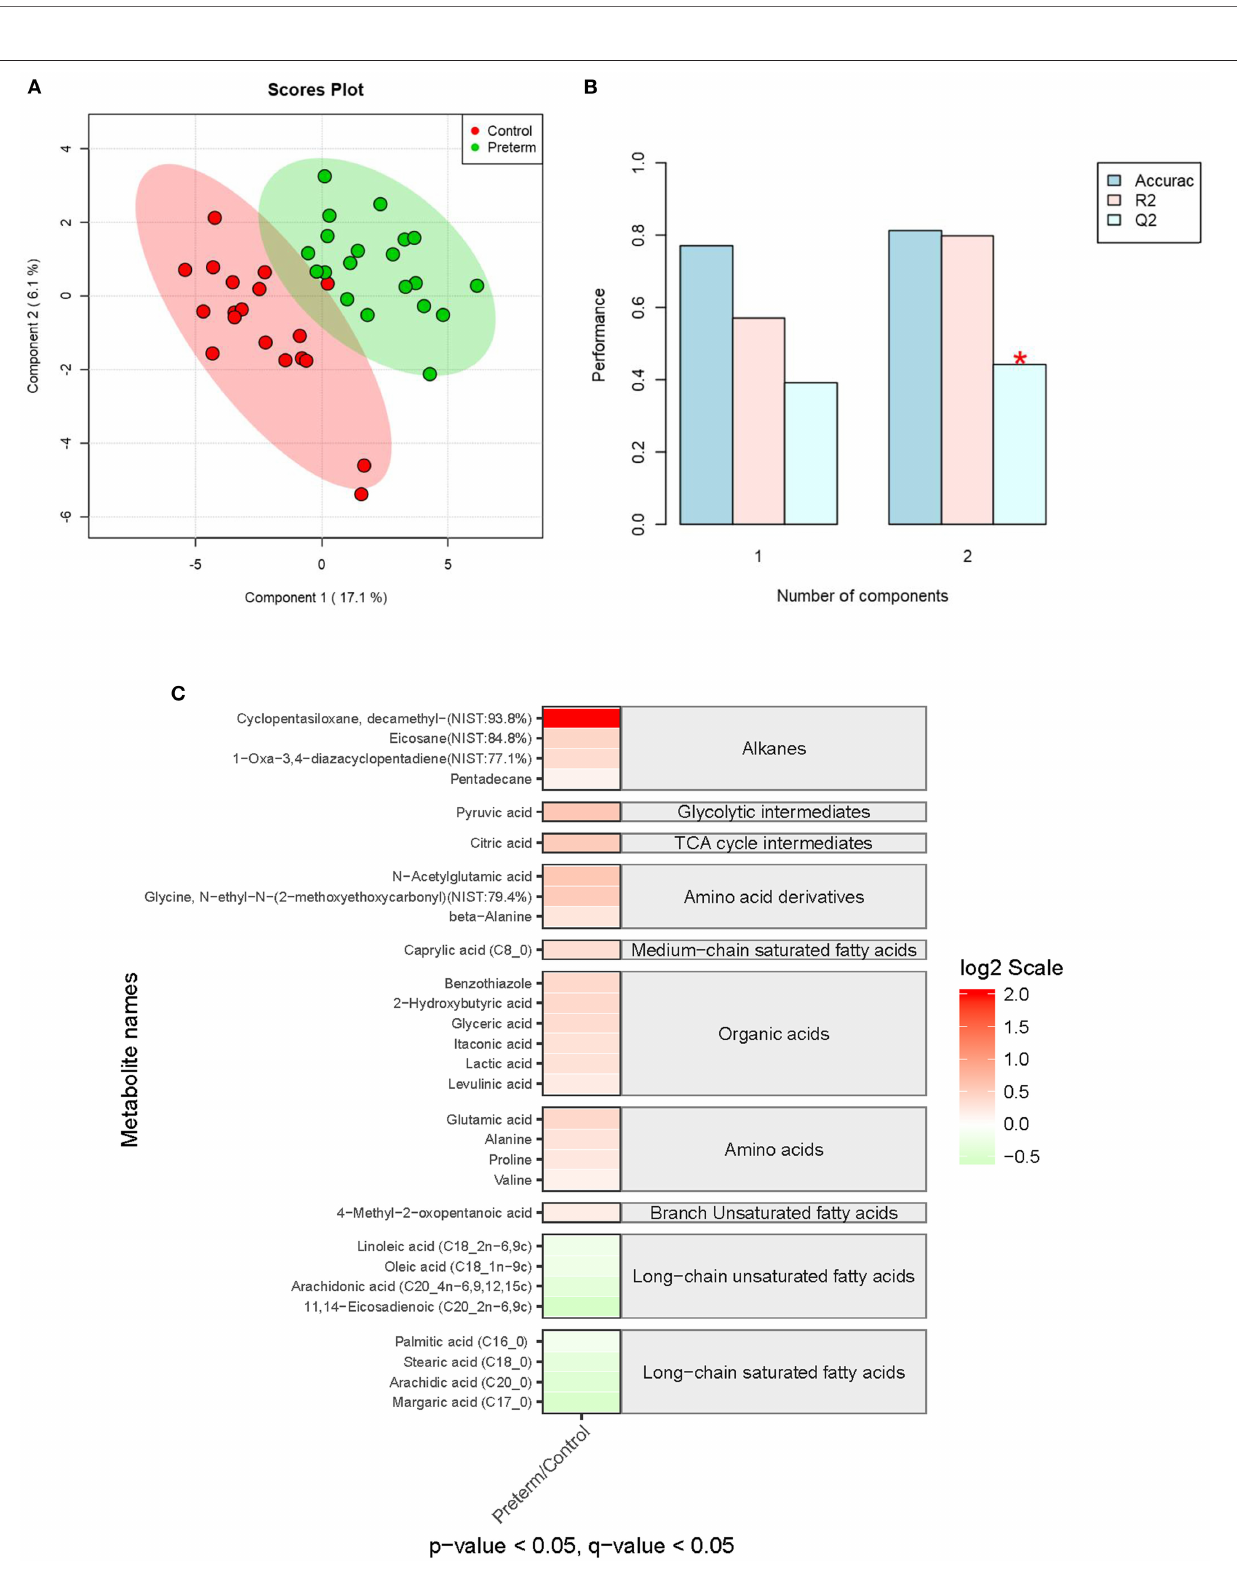
FIGURE 3 | Partial least squares discriminant analysis (PLS-DA) and the heatmap of the serum metabolome between the sPTB group and the full-term group. (A,B) PLS-DA of the serum metabolome between the sPTB group and the full-term group, including a measure of prediction model performance. (C) The heatmap shows the differentially expressed metabolites. The relative concentrations of serum metabolites were demonstrated through log 2 scale. The red color blocks indicate a higher expression level, and the green color blocks indicate a lower expression level. Only the metabolites with a p -value of < 0.05 and a q -value of < 0.05 were displayed.